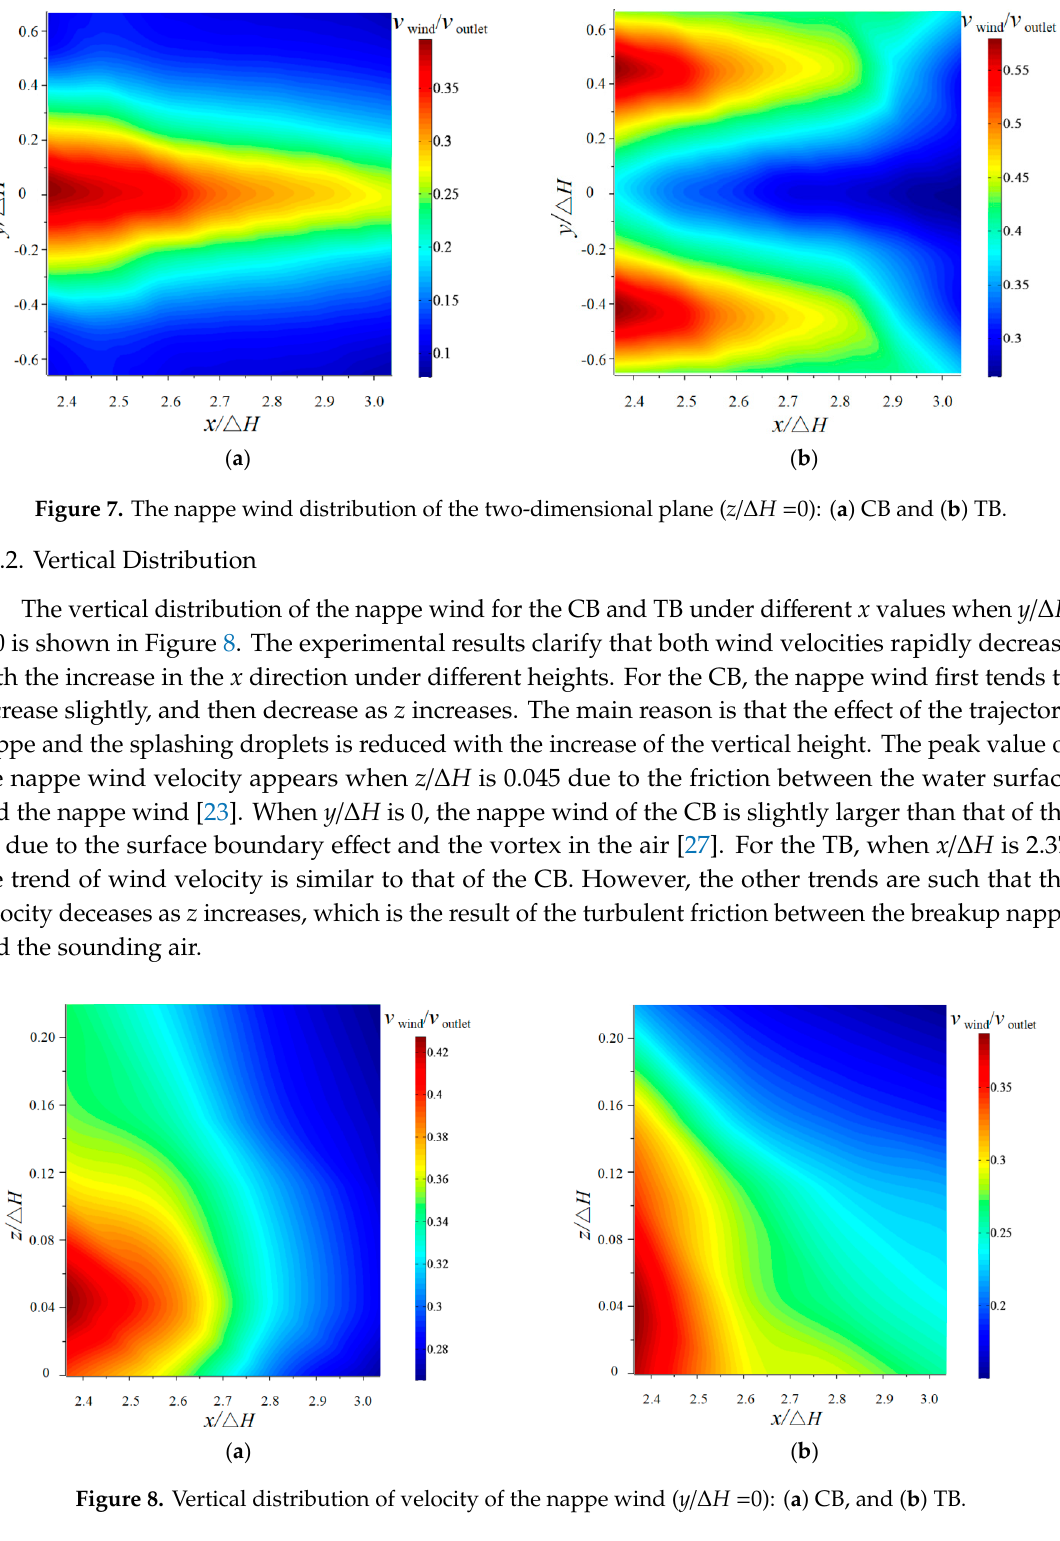
( b ) Figure 9. Vertical distribution of velocity of the nappe wind ( x/ Δ H =3.04): (a) CB and (b) TB. 3.3. Effects of Bucket Angles on Wind Velocity 3.3.1. Horizontal Distribution The bucket angle has a great influence on the flow regime of the trajectory nappe, and then it strongly affects the velocity distribution of the downstream nappe wind. The horizontal distribution of the nappe wind is measured under five different bucket angles when z/ Δ H is 0. The velocities when y/ Δ H is 0 and 0.448 respectively appear as the peaks for two buckets, so the distributions at two points are shown in Figure 10.